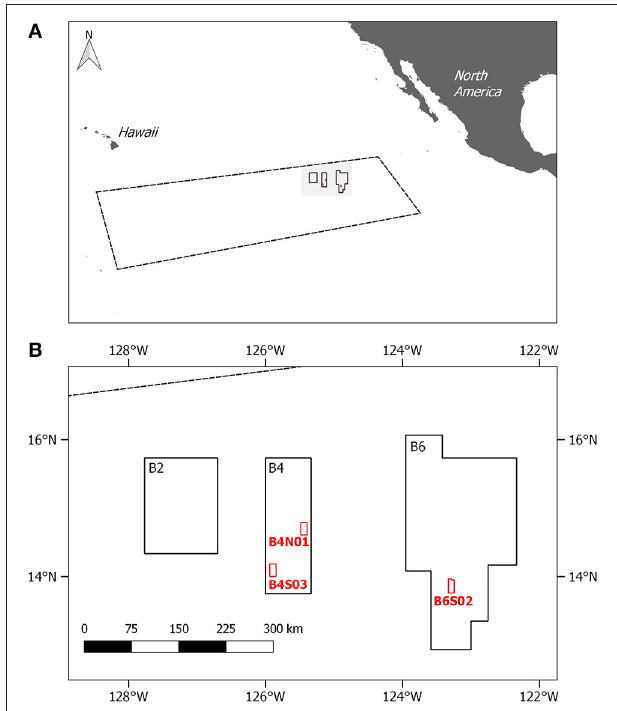
FIGURE 1 | (A) Location of the Clarion Clipperton Fracture Zone (CCFZ); coordinates based on the working definition of Glover et al. (2015) with an indication of the GSR license area. (B) Location of the three sites sampled within the GSR license area during GSRNOD15A (in red). Site B6S02 was also sampled for meiofauna and environmental variables during cruise